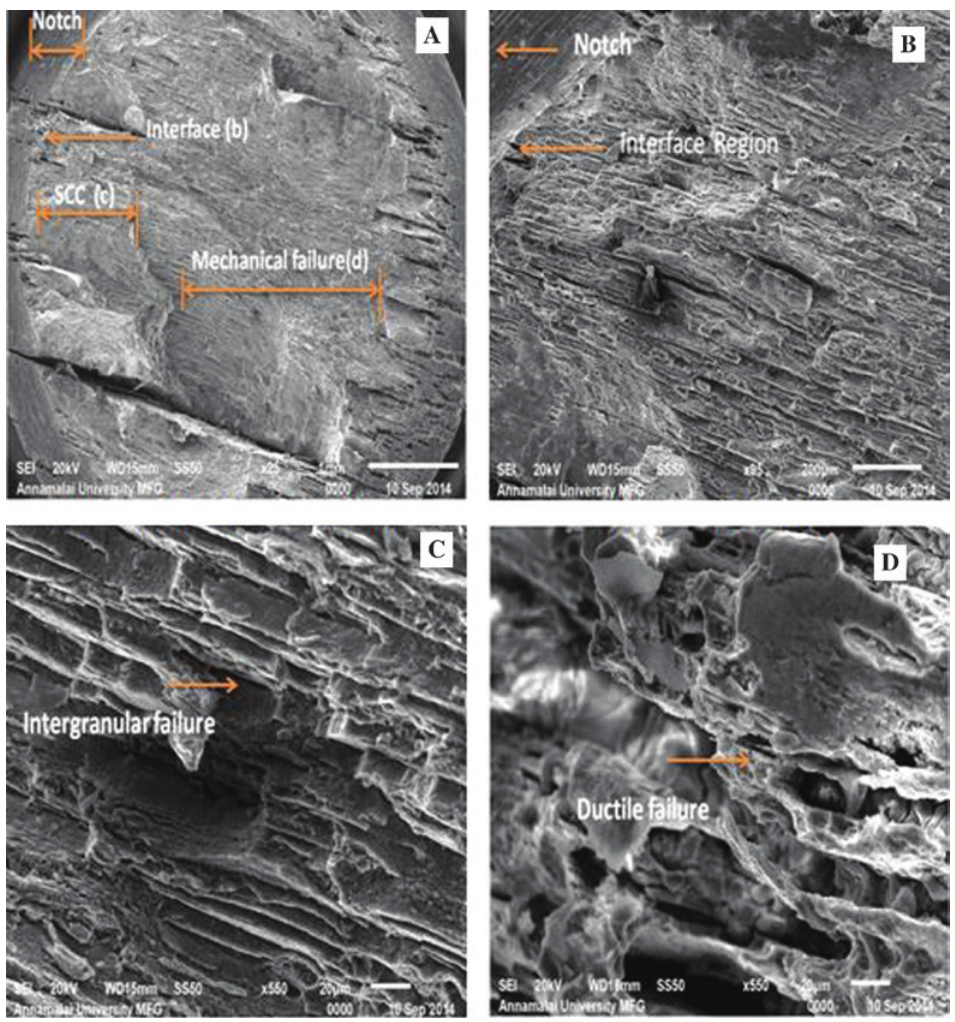
Figure 10: SEM fractographs of AA7075-T651 in a 3.5 wt.% NaCl